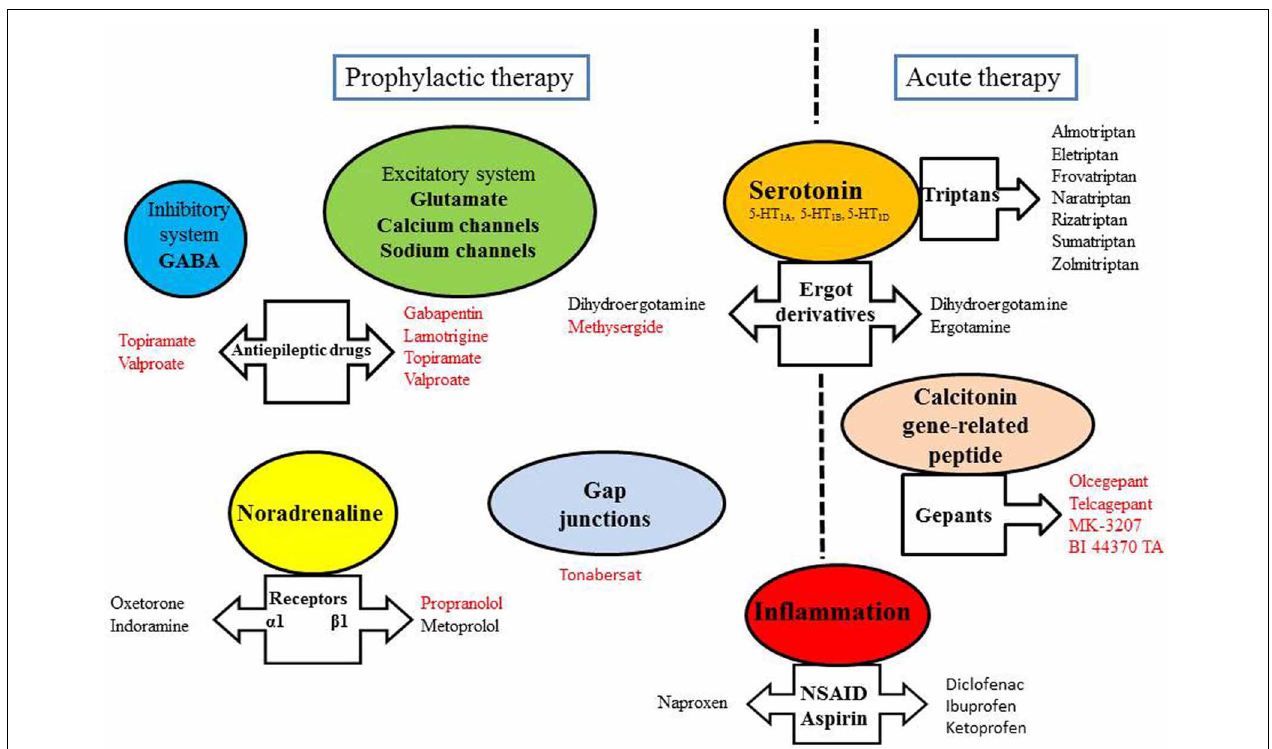
FIGURE 2 | Some targets of anti-migraine drugs. Drugs written in red have been shown to exert an inhibitory effect on